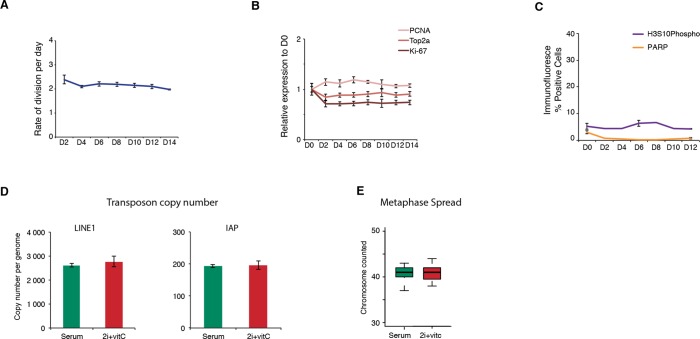
Cell proliferation, cell death, and genome integrity.(A) Mitotic division rate of J1 ES cells during the conversion from serum to 2i+vitC. Mean ± SEM between three biological replicates. (B) Quantification of proliferation marker expression by Nanostring. Data are expressed as fold change to D0 and represent mean ± SEM between seven biological replicates. (C) Percentage of cells immunostained against the apoptosis marker PARP and the mitotic marker H3S10 phosphorylation. Between 5000 and 10000 cells were counted at each time point. When available, data represent mean ± SEM between two biological replicates. (D) Absolute copy number of L1-ORF2 and IAPΔ1 fragments assayed by qPCR on genomic DNA. Values are expressed as copies per genome, representing the mean ± SEM between two biological replicates. (E) Chromosome numbers counted in 20 metaphase spreads in serum and 2i+vitC medium.